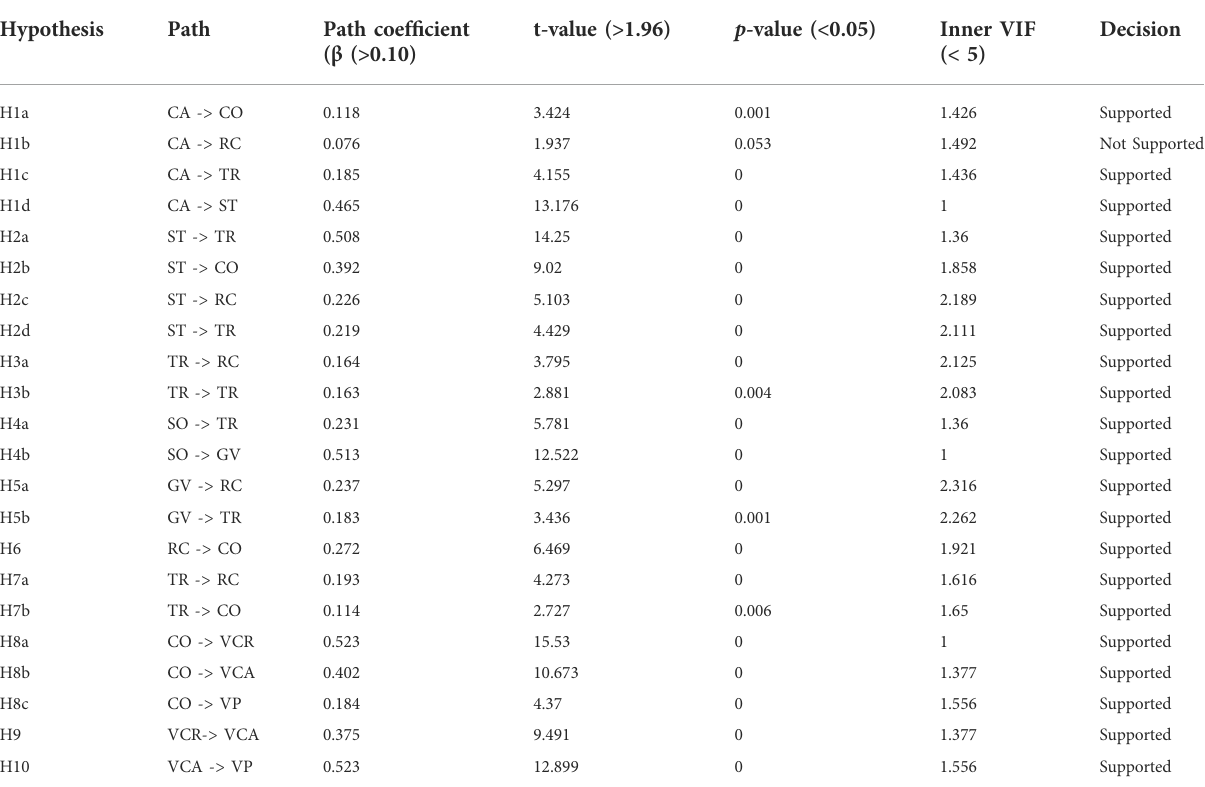
TABLE 8 Structural model